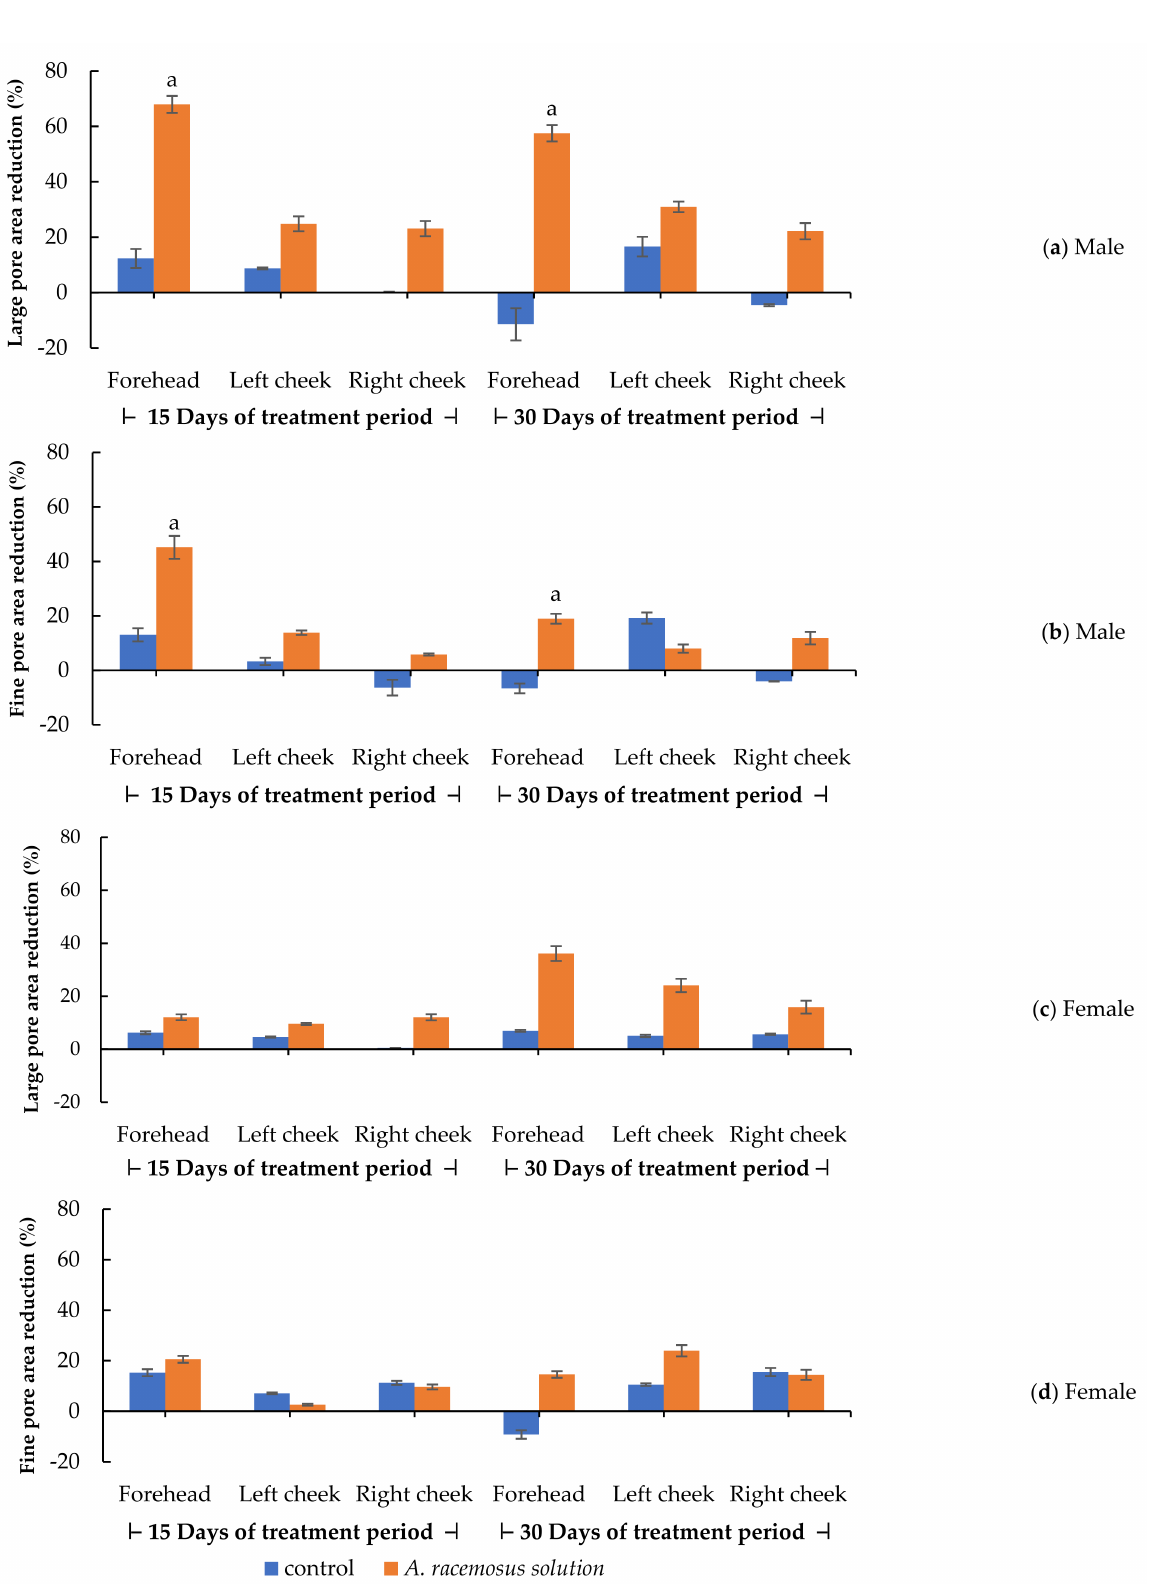
Figure 3. Pore area reduction of the control (5% of propylene glycol) and the 5% of Asparagus racemosus Willd. root extract solution groups on forehead, left cheek, and right cheek. ( a ) Large and ( b ) fine pore area reduction after 15 days and 30 days of treatment periods in male volunteers. ( c ) Large and ( d ) fine pore area reduction after 15 days and 30 days of treatment periods in female volunteers. Statistical significance in comparison to the control is indicated as “a” ( p <